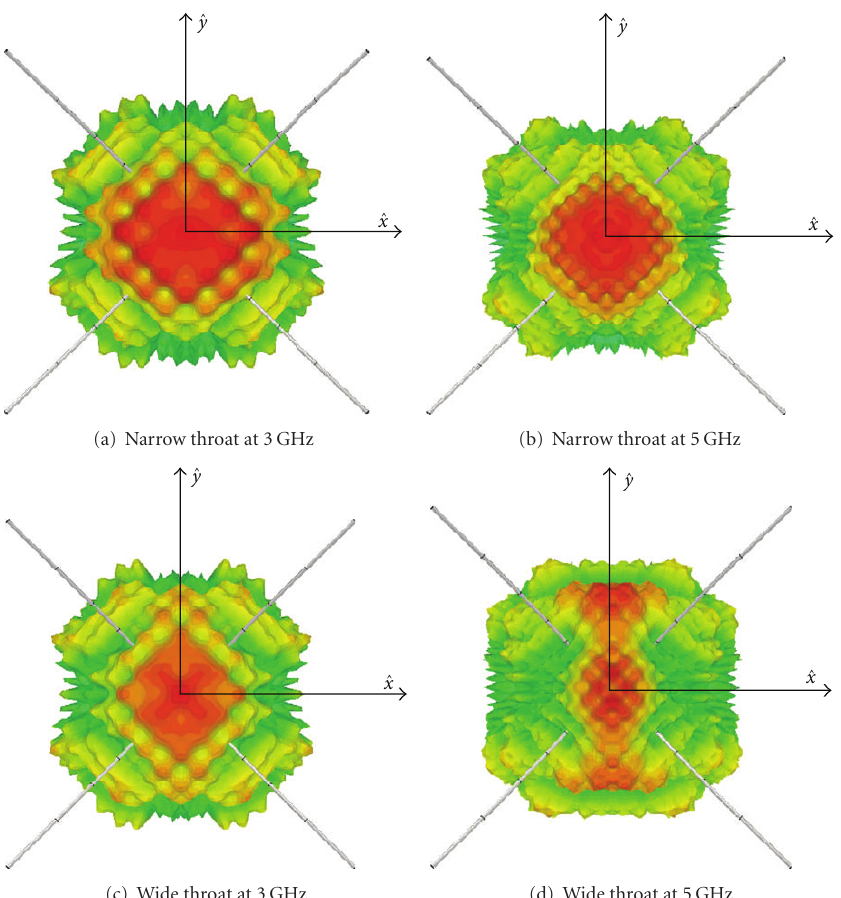
Figure 3: Comparison of three-dimensional radiation patterns of the two TEM-wire horns. With a wide throat region, the symmetry along both of the x - and y -axes is broken at higher